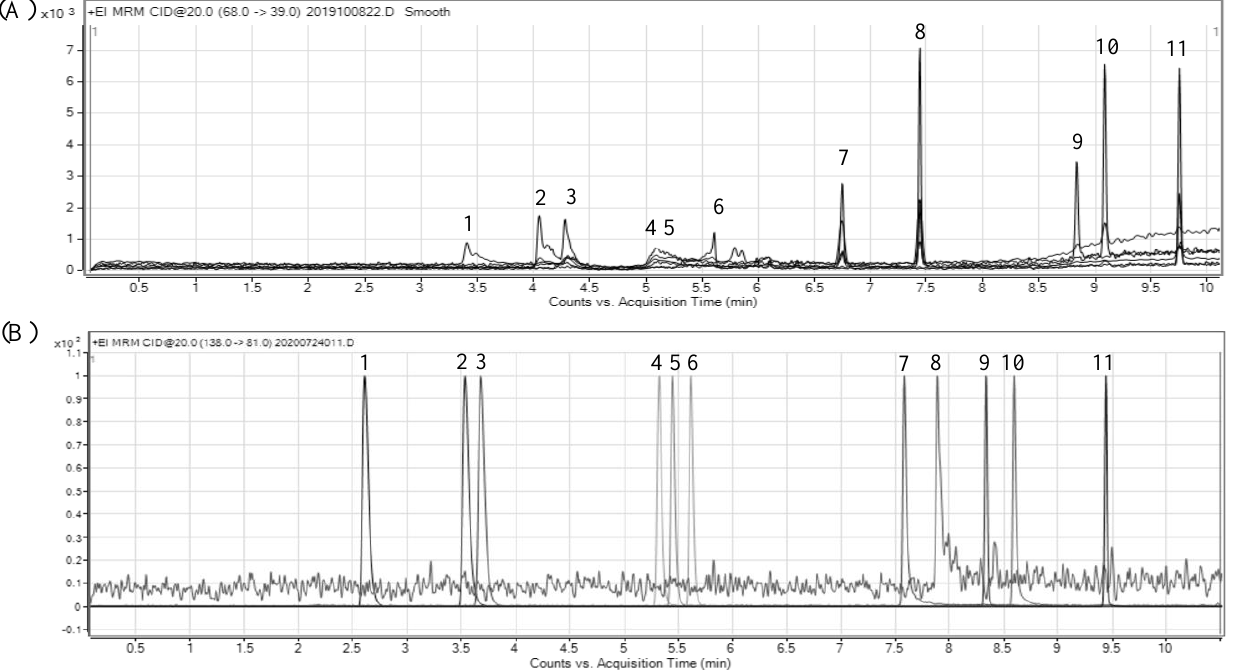
Figure 1. GC − MS/MS chromatogram of furan and its 10 derivative standards by ( A ) HP − WAX and ( B ) HP − 5MS columns. Peak identification: (1) furan, (2) 2-methylfuran, (3) 3-methylfuran, (4) 2-ethylfuran, (5) 2,5-dimethylfuran, (6) 2,3-dimethylfuran, (7) furfural, (8) furfuryl alcohol, (9) 2-butylfuran, (10) 2-acetylfuran, (11) 2-pentylfuran.